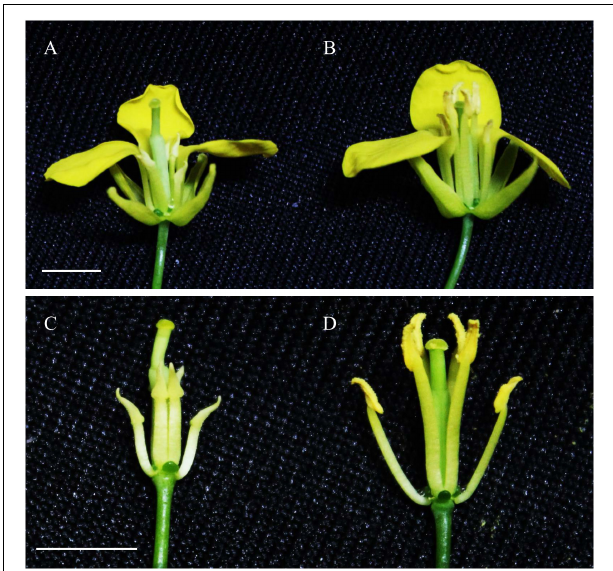
FIGURE 1 | Phenotypic characterization of floral organs. (A,C) Sterile flower of CMS line WNJ01A . (B,D) Fertile flower of restorer line Hui01 . Bars = 0.5